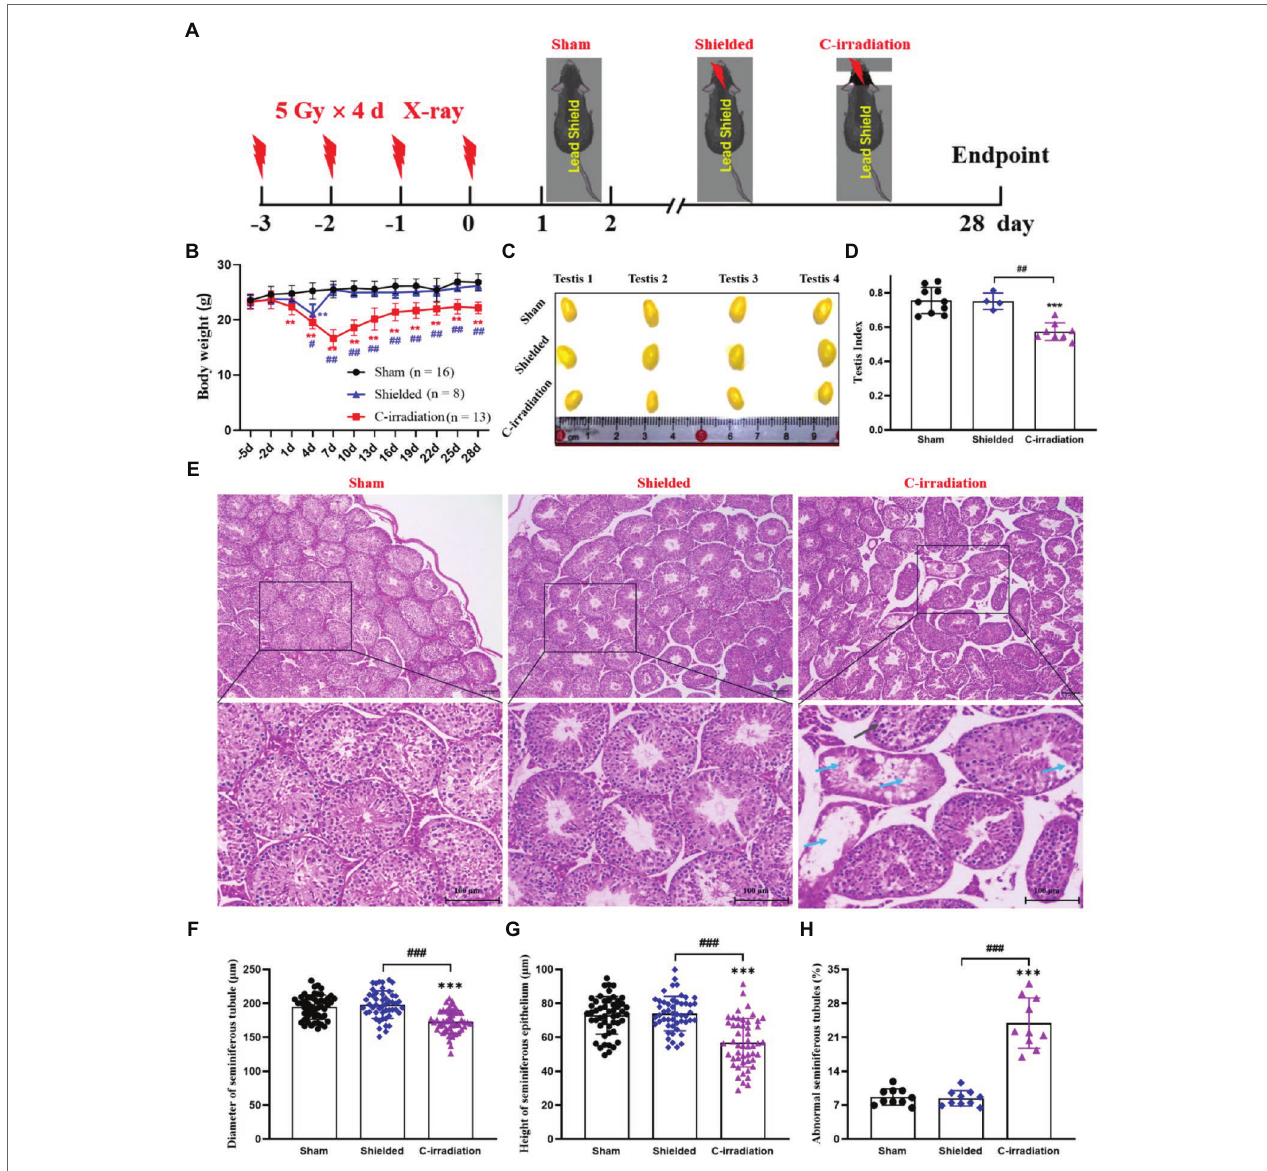
FIGURE 1 | The abscopal effects of C-irradiation damage testicular histology. (A) Time schedule of irradiation for mice. (B) Body weight of mice during experiments. (C) Testis volume, n = 4 for each group. (D) Testis index, n = 10 for the sham group. n = 4 for the shielded group and n = 8 for the C-irradiation group. (E) HE staining of testes, n = 4 for the sham and C-irradiation groups, n = 2 for the shielded group, bar = 100 μ m. Vacuolation of seminiferous tubules ( ) and degeneration and necrosis of various spermatogenic cells ( ). (F – G) Diameter of seminiferous tubules and height of seminiferous epithelium calculated randomly from 50 round or nearly round cross-sections of the seminiferous tubules (long axis: short axis < 1.2:1) for each group. (H) Percentage of abnormal seminiferous tubules calculated from 10 random fields for each group. The values are expressed as the mean ± SD and analysed by two-way ANOVA for body weight and one- way ANOVA with Tukey’s test for three-group comparisons. ** p < 0.01; *** p < 0.001 vs. sham group. ## p < 0.01; ### p < 0.001 vs. shielded